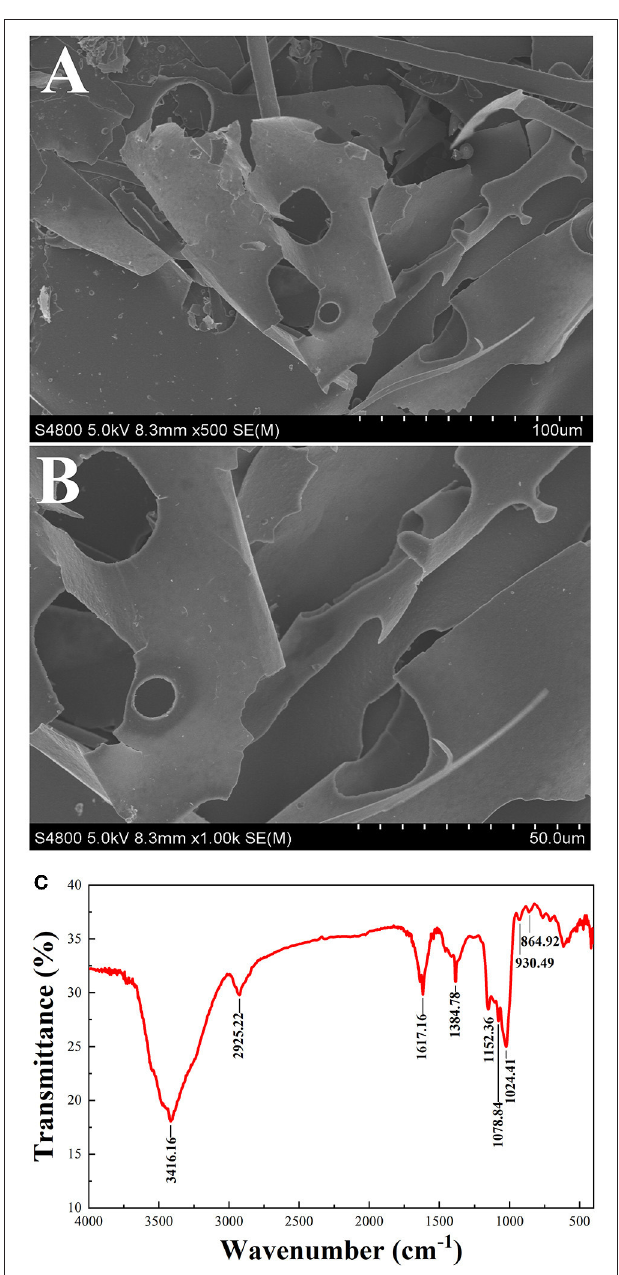
FIGURE 2 | SEM (500 × 1,000 × ) of PSP-1 (A,B) FT-IR spectra of PSP-1 in the range of 4,000–400 cm − 1 (C) .